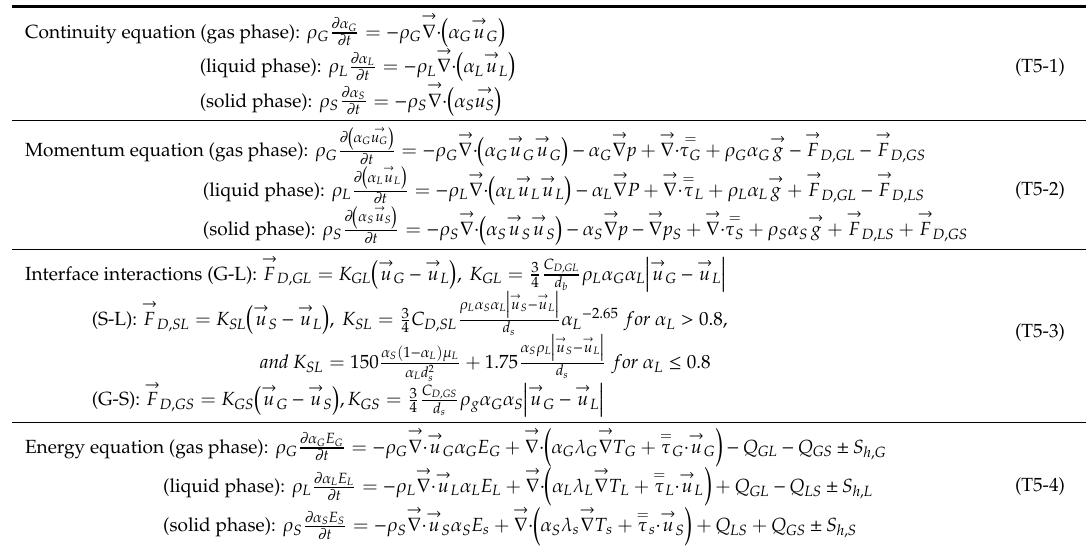
Table 5. EM-KTGF-CFD model for gas-liquid-solid phases